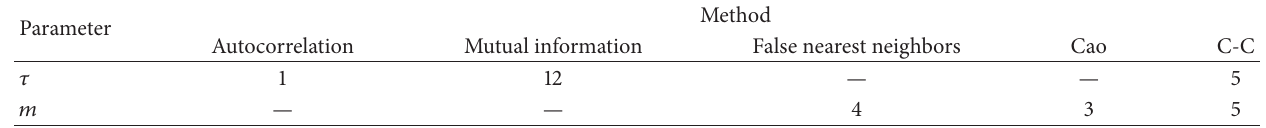
Table 2: Comparison among phase space reconstruction methods.